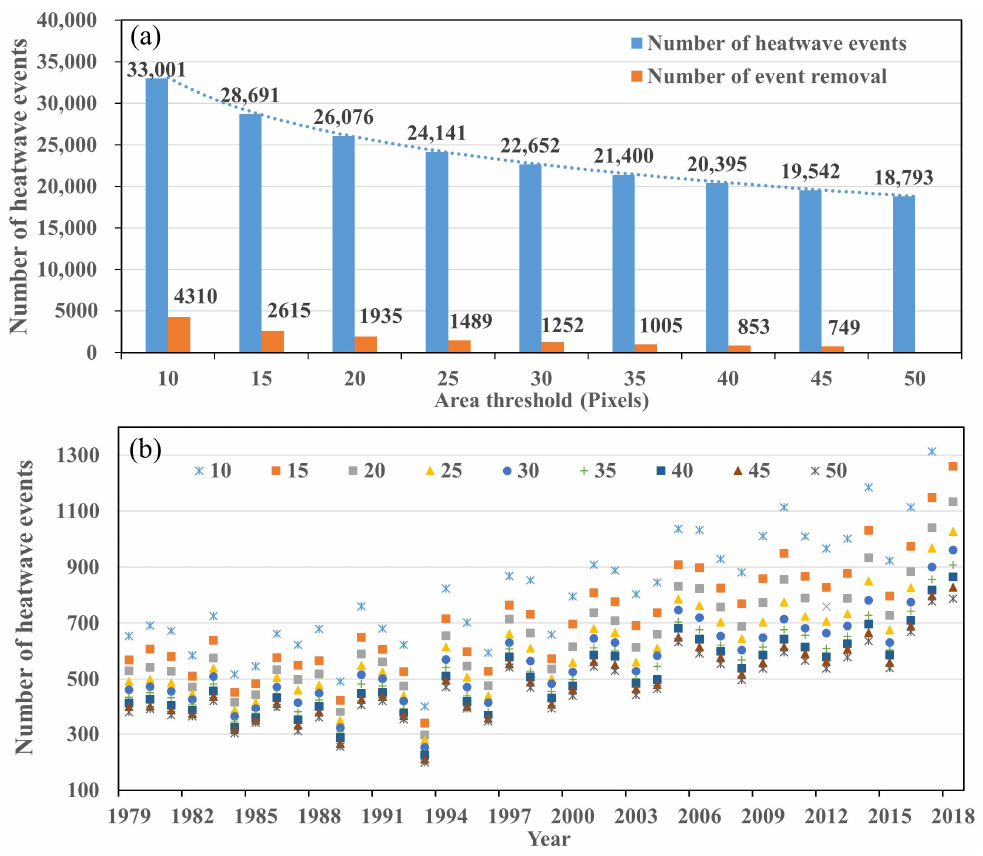
Figure 17. Sensitivity test between the number of heatwave events and area thresholds. ( a ) Cumulative events in the 1979–2018 period and ( b ) heatwave events in an individual year from 1979 to 2018. It was noted that the number of heatwave events represents all individuals during the study period before judging whether they belong to the same event.